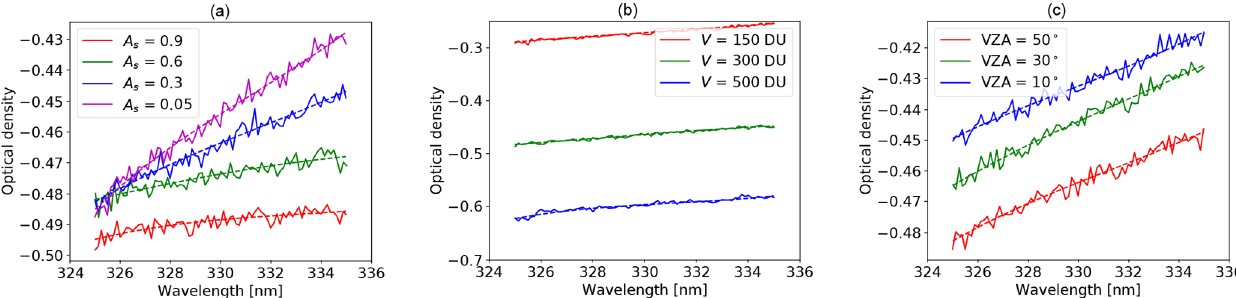
Figure 4. Optical densities of the DOAS polynomial as a function of wavelength, with respect to (a) surface albedo, (b) total ozone, and (c) viewing zenith angle. The dotted lines represent the DOAS-fitted